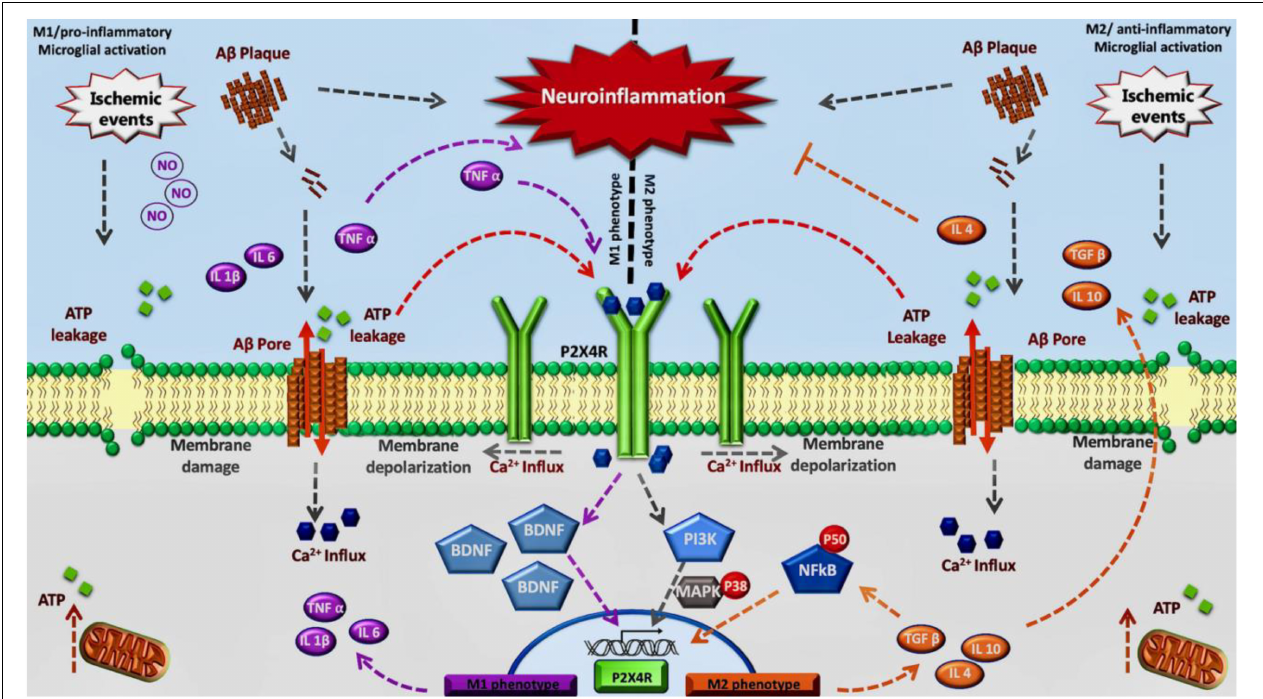
FIGURE 1 | Inhibition of P2X4R in the acute phase could mitigate the effects of M1 transition allowing the appearance of the M2 phenotype: We propose this model considering that in the early stage P2X4 receptors contribute to maintain the M1 phenotype through TNF- α and BDNF signaling. Also, during a final stage, P2X4 may contribute to maintaining M2 phenotype by NF κ B